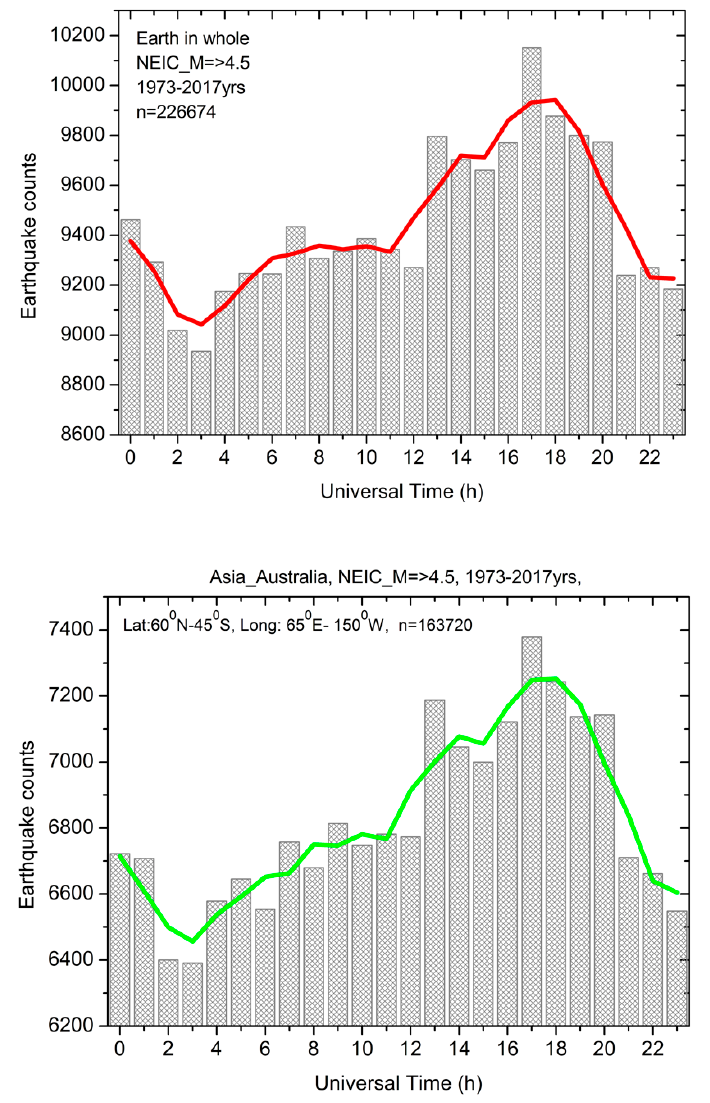
Figure 12. Top panel—UT distribution of the global seismic activity for the time period 1973–2017. Bottom panel—UT distribution of the seismic activity in the Asia-Australia longitudinal sector for the period 1973–2017.